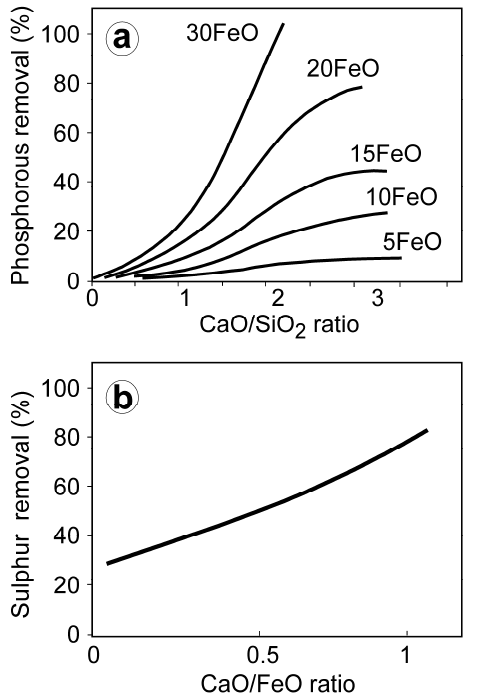
Fig. 5 – (a) Evolution of the Phosphor release depending on the CaO/SiO 2 ratio. It explains the great abundance of wüstite in the Getafe slag heaps: large amounts of it were produced in the manufac- turing process to induce greater dephosphorylation of the iron. (b) Sul- phur removal versus CaO/FeO ratio. It makes clear the abundance of calcium-iron silicates: large amounts of them were produced to induce greater desulphurisation during the second manufacturing